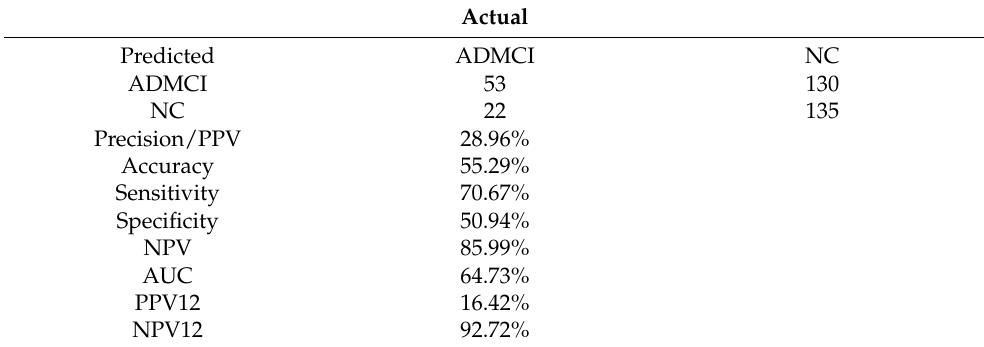
Table 4. Performance for testing set in 10 times repeated fivefold cross-validation after hyperparame- ter